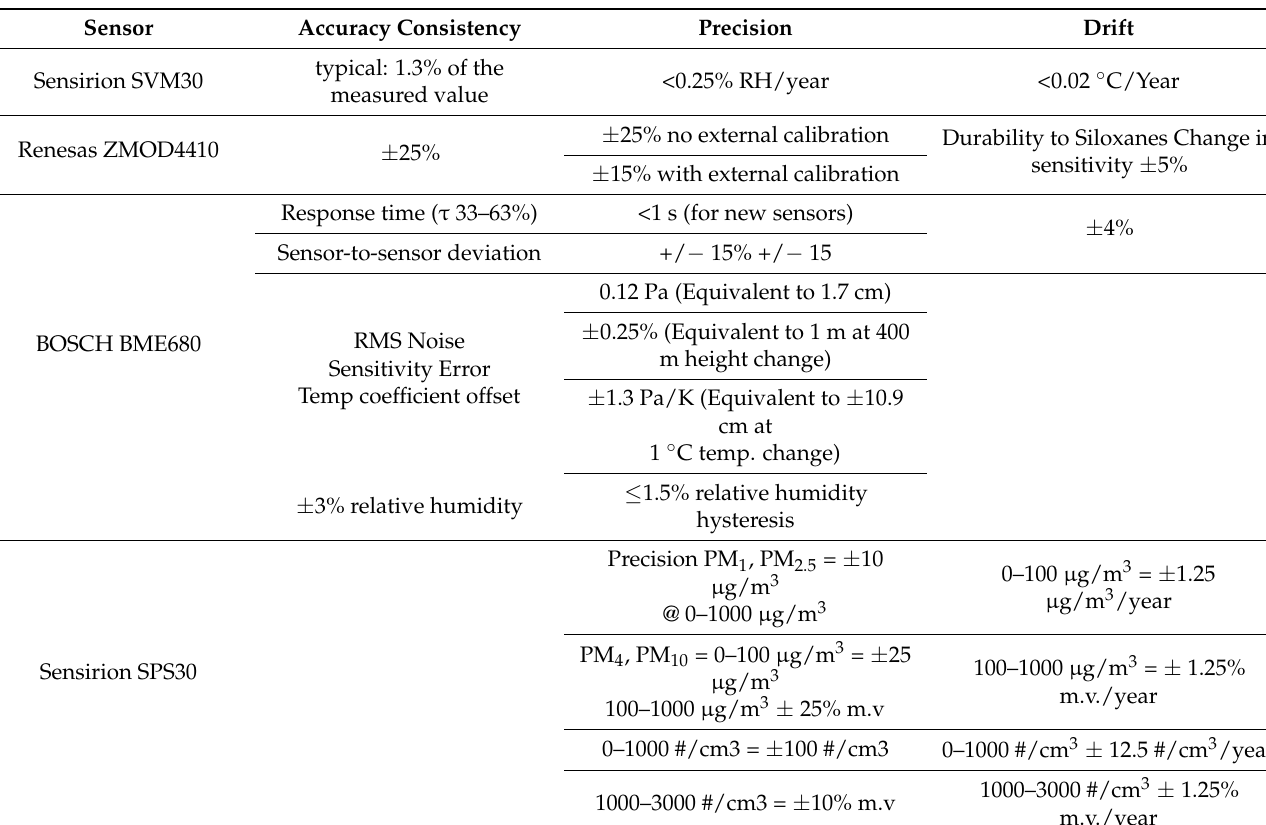
Table 3. Sensors’ accuracy and precision.